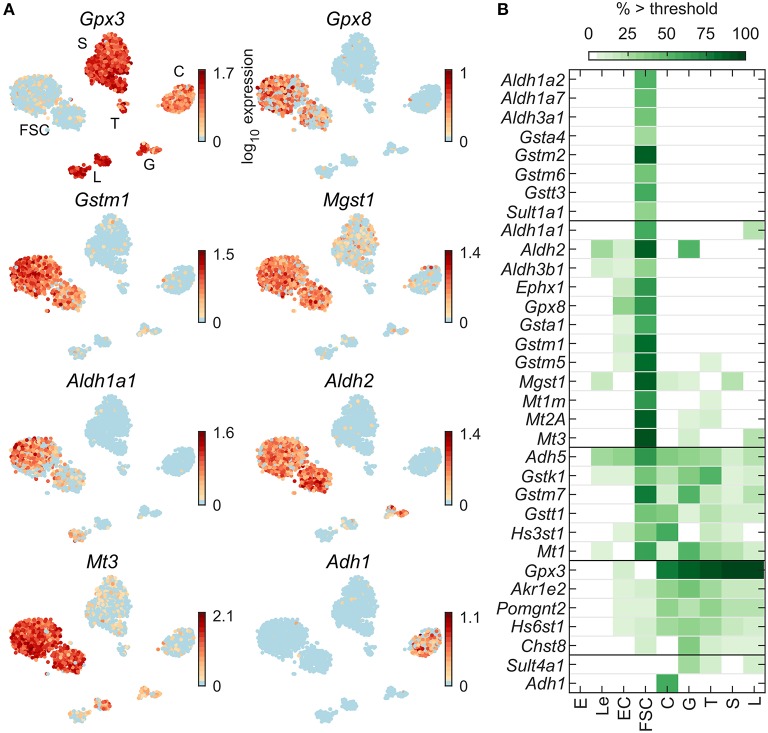
Expression of detoxification enzyme genes. (A) tSNE map showing expression of select genes from the following families: selenoproteins (Gpx3, Gpx8), glutathione S-transferases (Gstm1, Mgst1), aldehyde dehydrogenases (Aldh1a1, Aldh2), metallothioneins (Mt3), and alcohol dehydrogenases (Adh1). (B) Percentage of cells per type expressing select genes above threshold. From a manually selected list of detoxification enzyme genes, 79 were expressed in at least 5% of cells in at least one cell type (Table 2) and all 33 pituitary-dominant genes are shown.